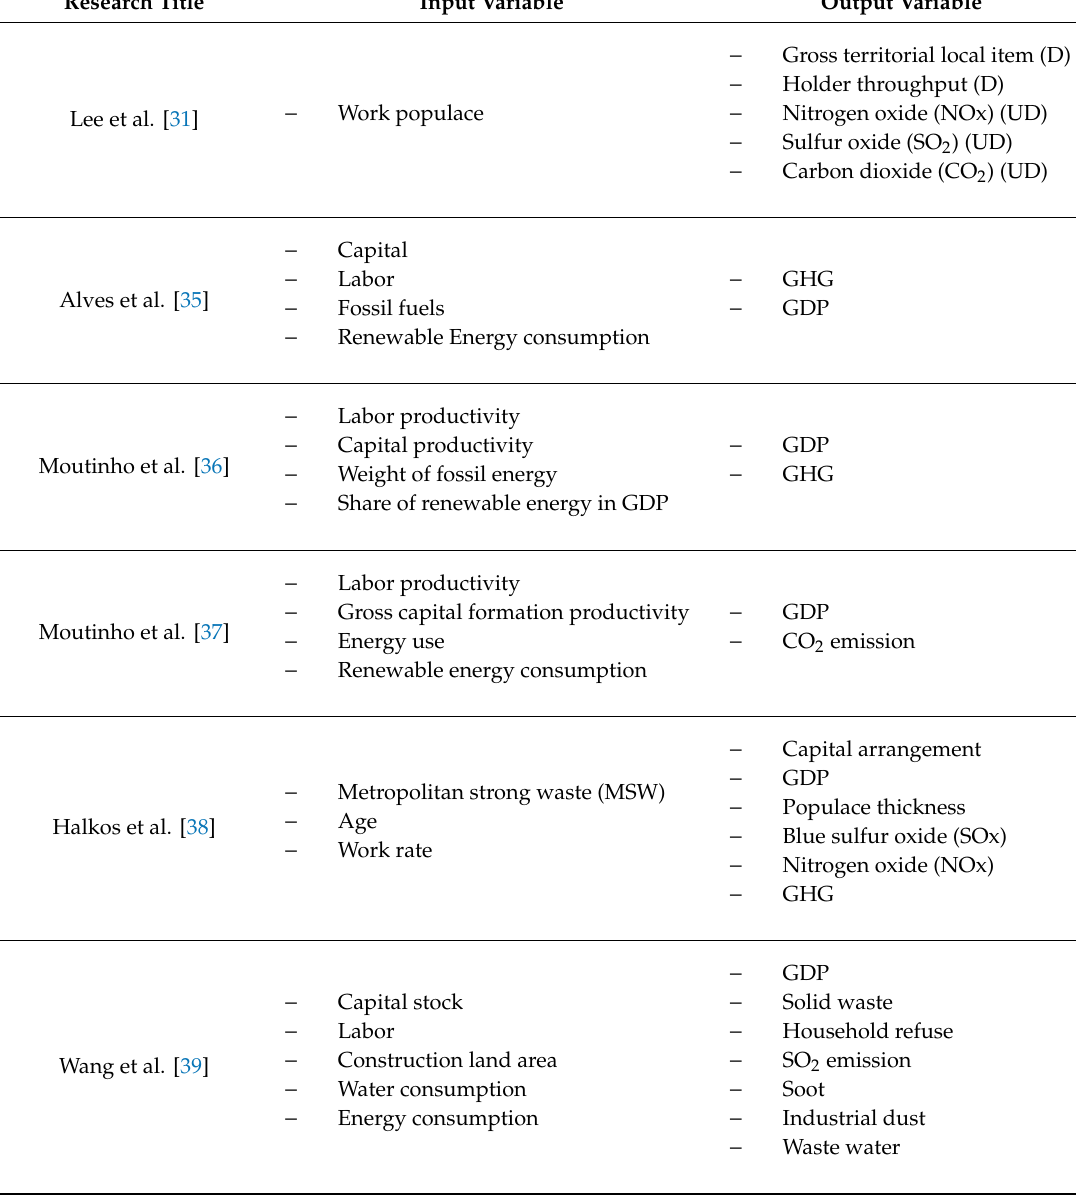
Table 2. Summary of input and output variables used in previous studies.